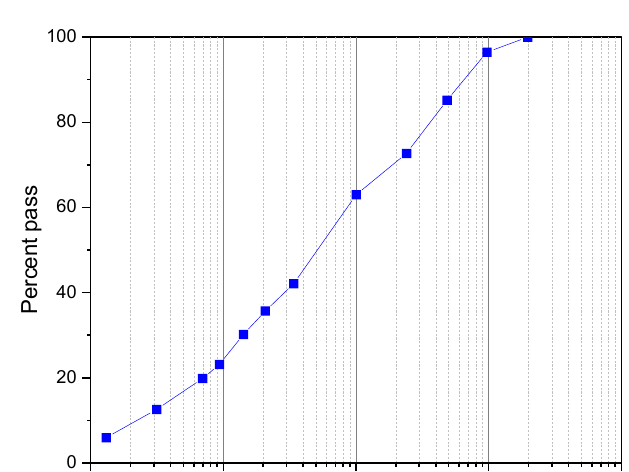
0.001 Figure 2. Natural BCS particle size distribution curve. Figure 2. Natural BCS particle size distribution curve. From the particle size distribution